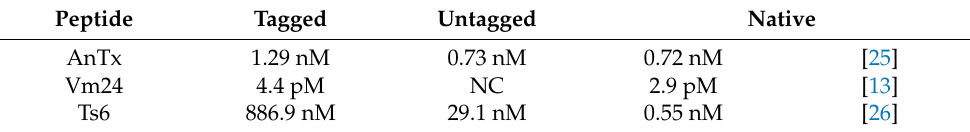
Table 2. Comparison of tagged and untagged peptide Kd values on hKv1.3.